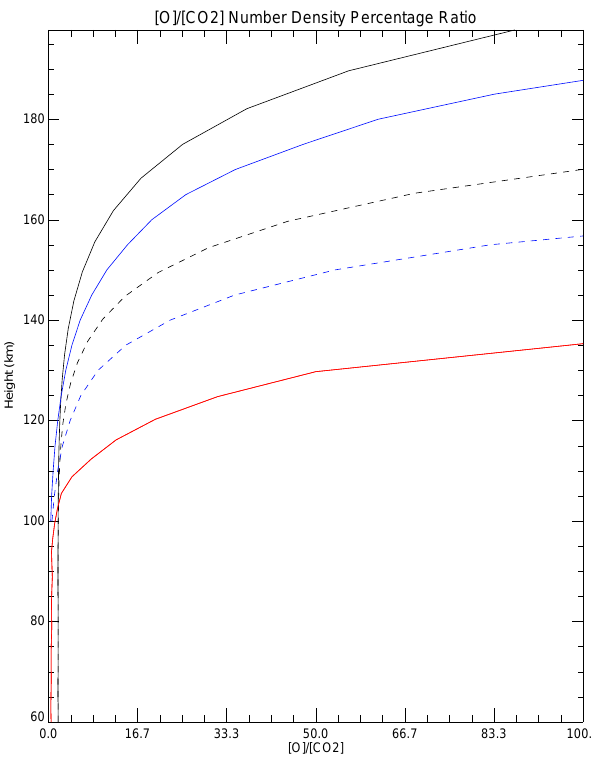
Fig. 3. O:CO 2 neutral number density ratio profiles at L s =90 ◦ , from MarTIM (black lines) and MTGCM (blue lines) (Bougher, 2007b), for 15:00LST (solid lines) and 05:00LST (dashed lines) at the equator. The solid red line is the MarTIM initial